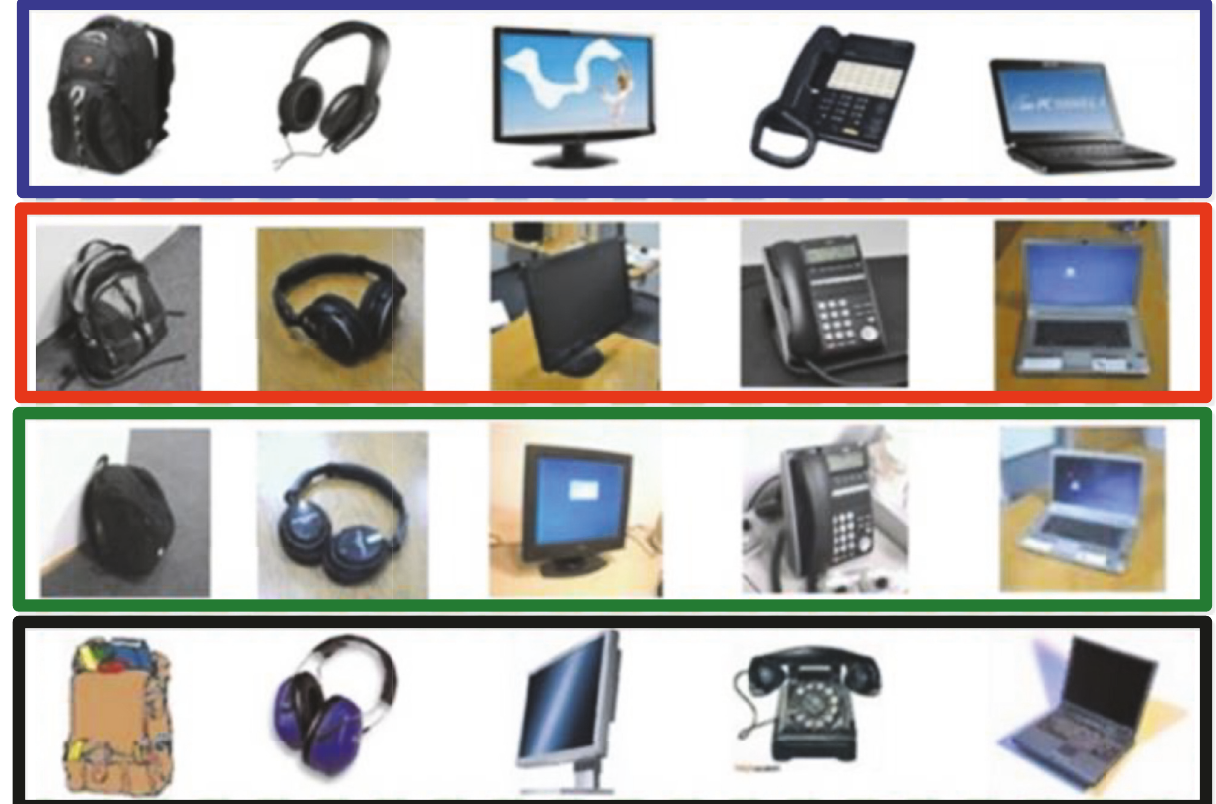
Figure 7: Examples of object images from 4 sources: Amazon (1st row), DSLR (2nd row), Webcam (3rd row), and Caltech (4th